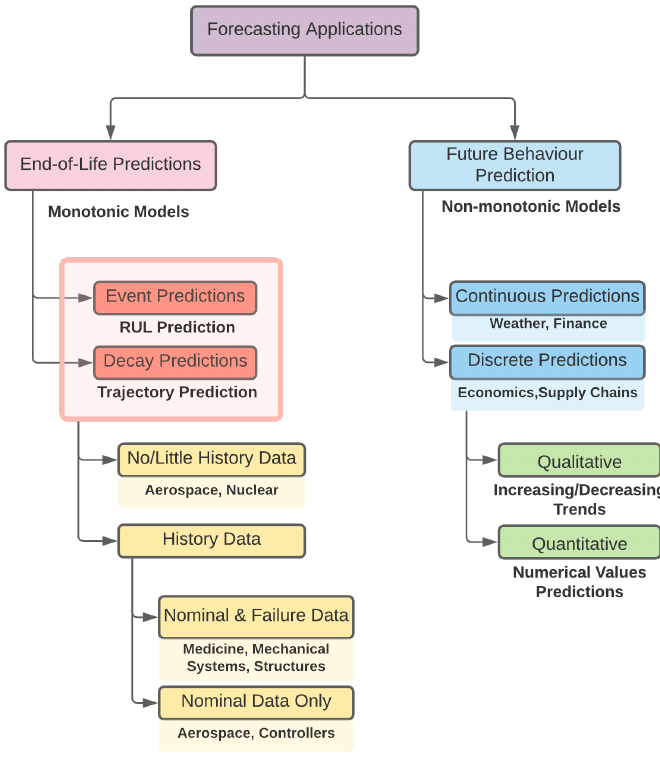
Figure 1. Different forecasting categories for various applications [12].